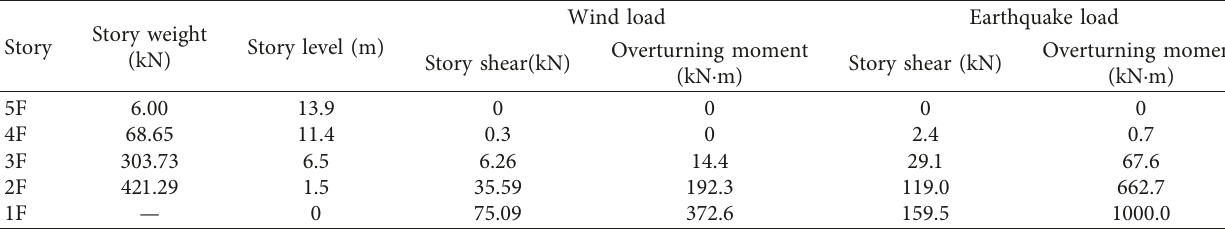
Table 2: Wind load and earthquake